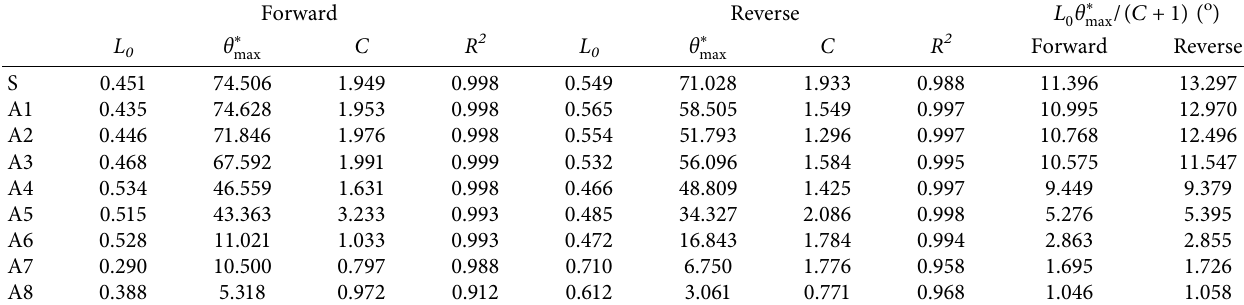
θ ∗ / ( C + 1 ) under different decomposition levels. 0 max